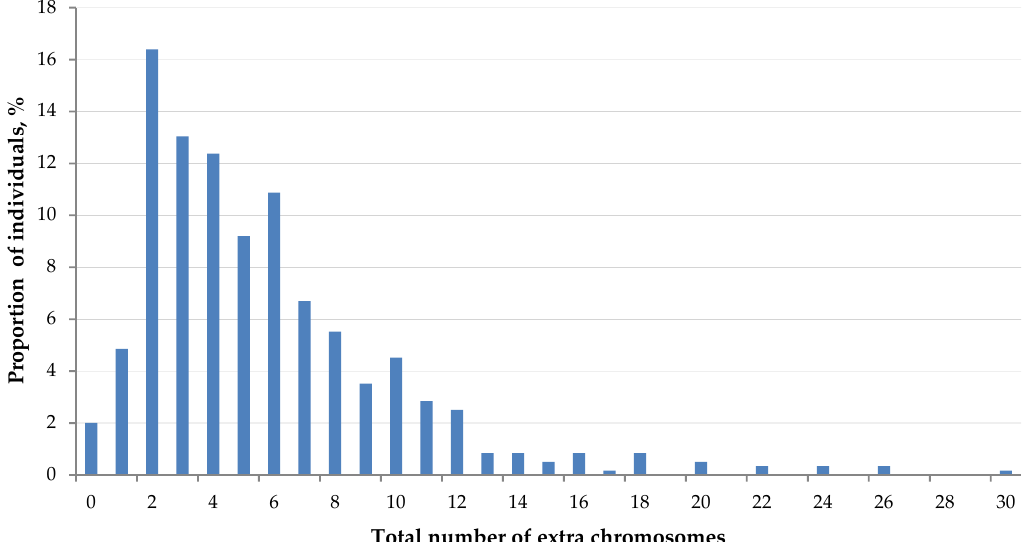
Figure 6. Ratio of A. peninsulae karyotypes with total number of extra chromosomes regardless of the type across examined local populations.